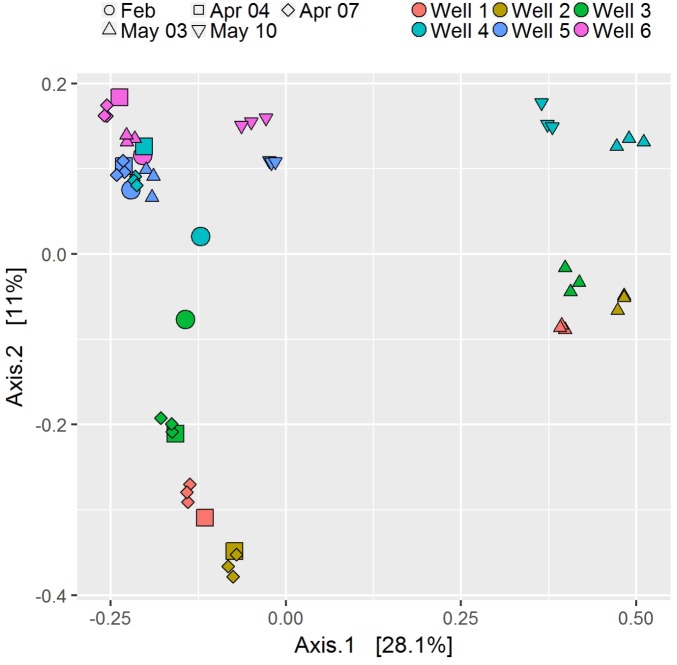
Principle coordinate analysis based on Bray–Curtis dissimilarity of all samples. Triplicates are shown as smaller symbols.